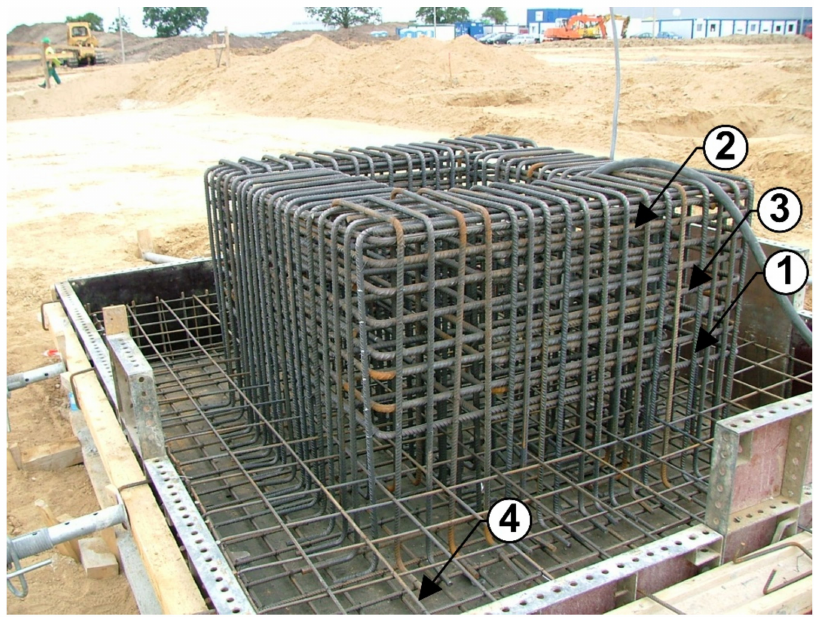
Figure 5. Reinforcement skeleton of PF; description in the